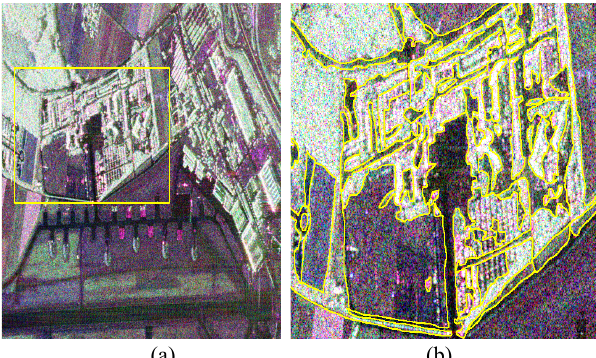
Fig. 2. ESAR L-band image from the Oberpfaffenhofen area in Germany. (a) Pauli RGB image. (b). The yellow lines are superimposed onto Pauli RGB image, depicting the ground truth segments.